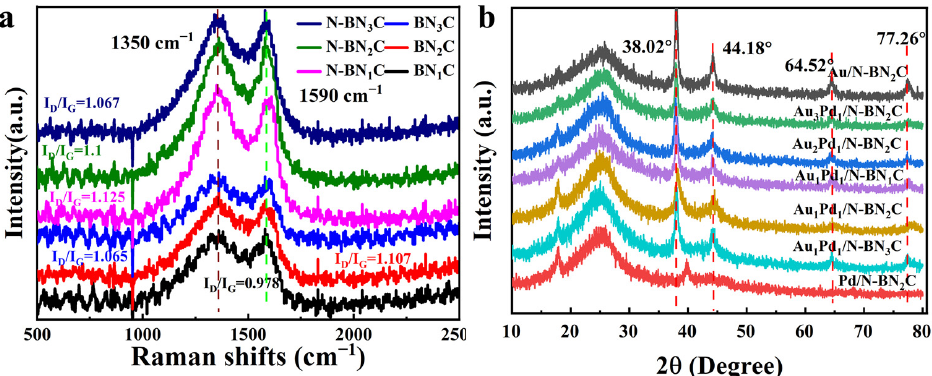
Figure 5. Raman spectra of BN x C and N-BN x C ( a ) and XRD spectra of Au m Pd n /N-BN x C ( b ) (x = 0, 1, 2, 3).